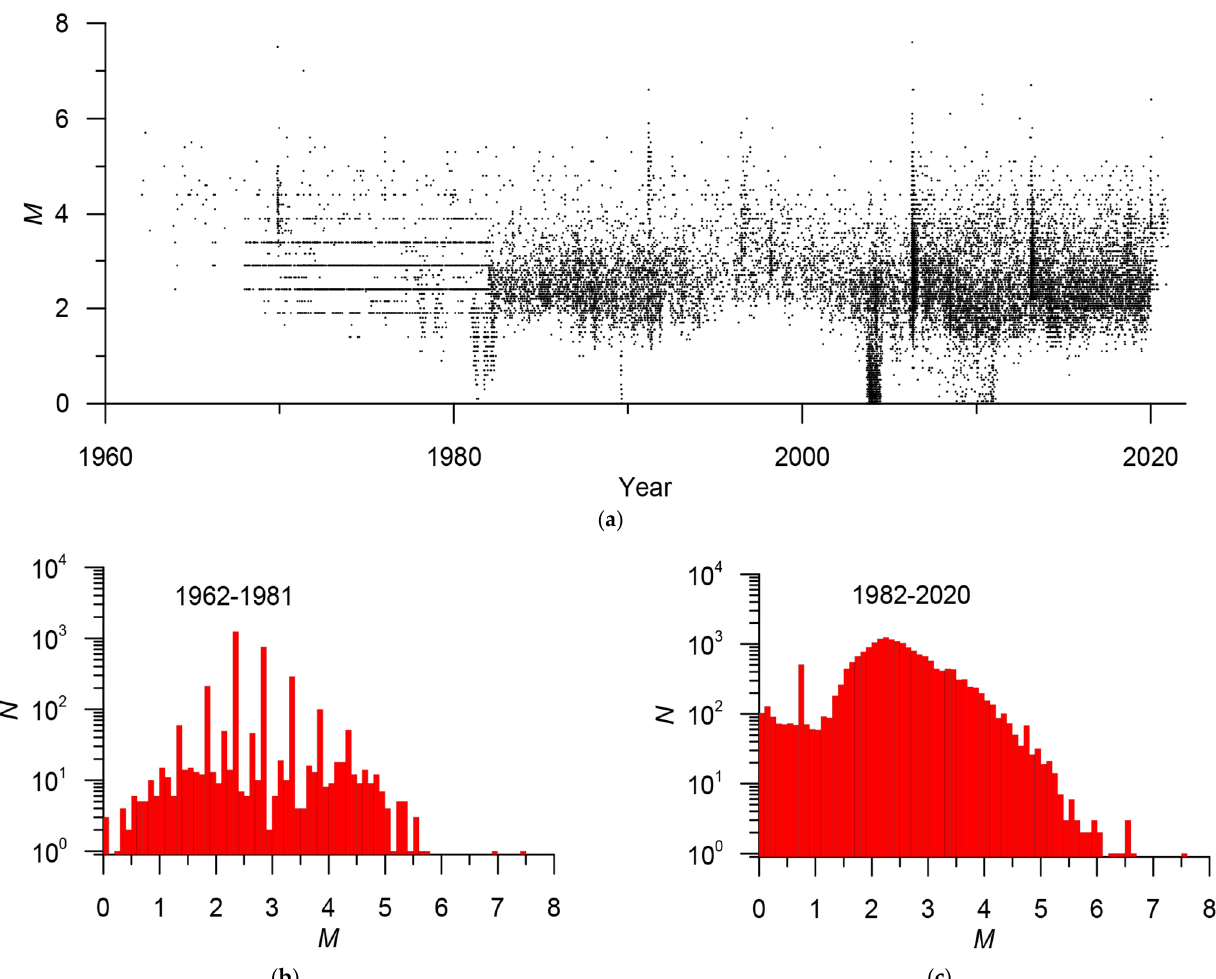
Figure 20. ( a ) Distribution of the magnitude of events in time. ( b , c ) Magnitude–frequency graphs before 1982 ( b ) and after 1982 ( c ). Before 1982, the energy classes were integers, and so the magnitudes are in increments of 0.5.